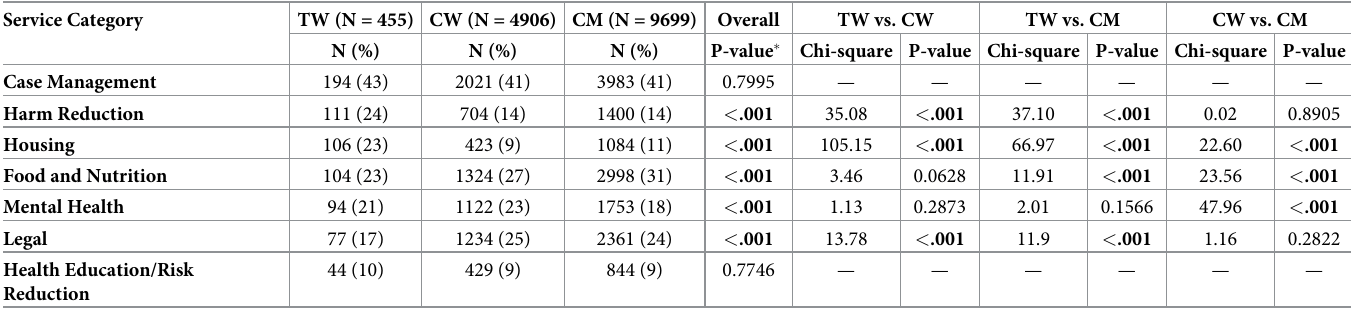
Table 2. Ryan White Part A service category utilization by gender, 2016-2017. Service Category